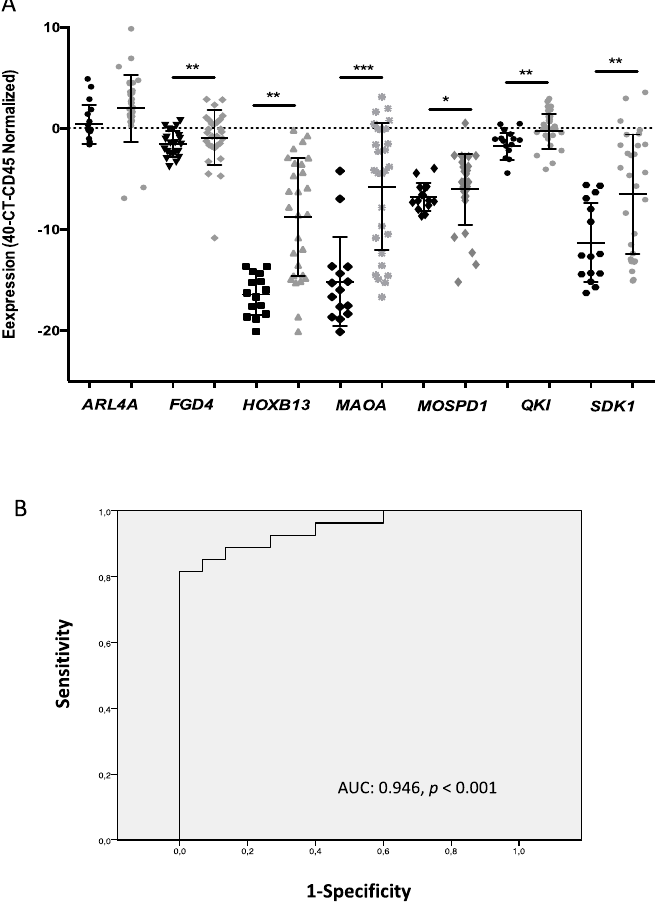
Figure 2. Validation of a CTC gene panel identified after a global gene expression array. ( A ) Gene expression levels of ARL4, FGD4, HOXB13, MAOA, MOSPD1, QKI , and SDK1 analyzed in a cohort of 28 mCRPC patients and 15 controls. * p < 0.5, ** p < 0.05, *** p < 0.005 according to the Mann–Whitney U-test. ( B ) ROC curve analysis to discriminate the control and the patients’ group using a regression model combining the FGD4, HOXB13, MAOA, MOSPD1, QKI , and SDK1 expression